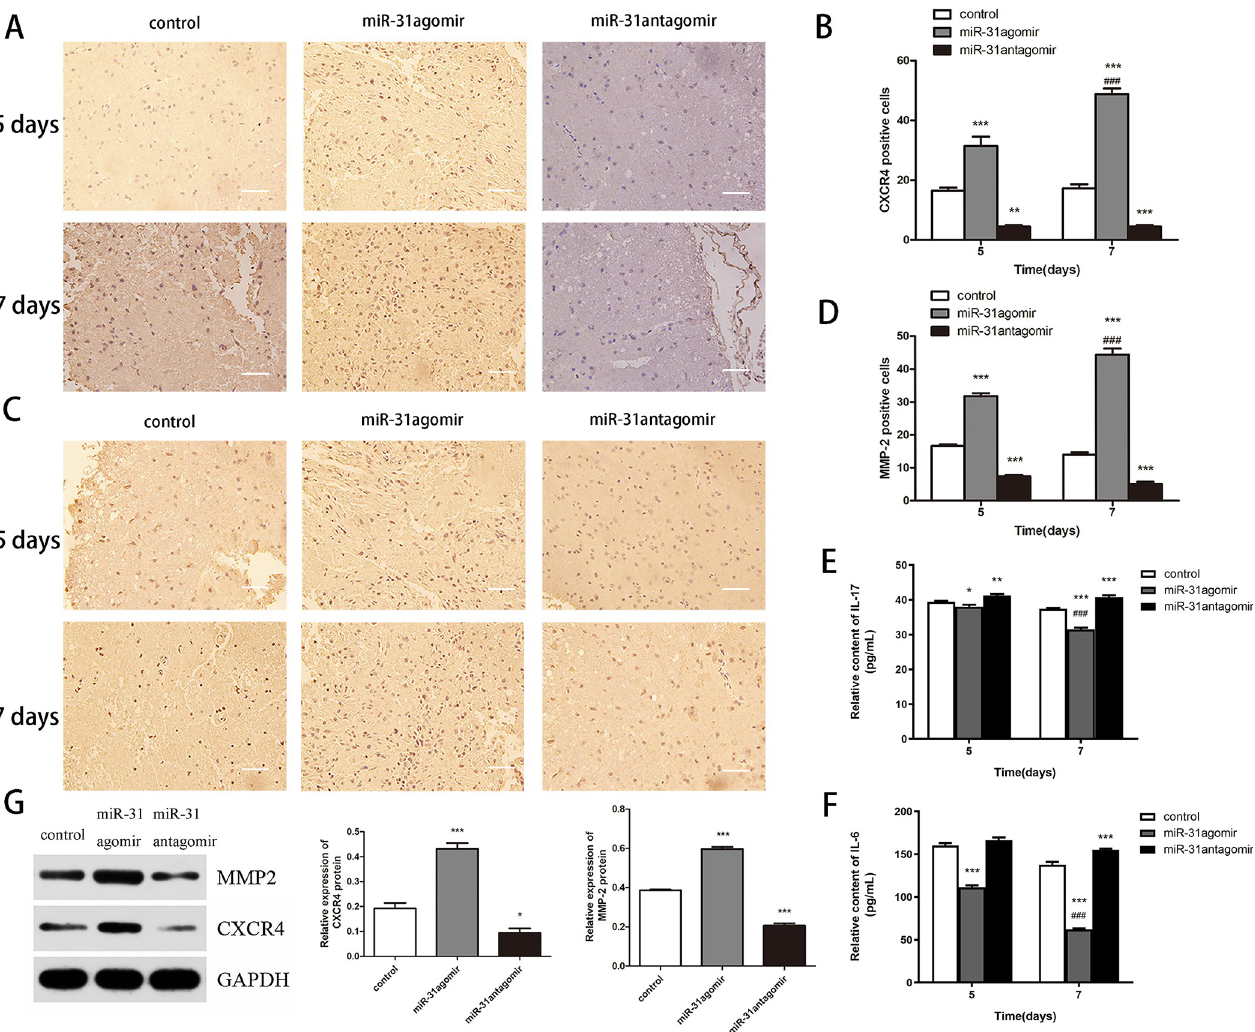
Fig 7. miR-31 upregulated the expression of CXCR4 and MMP-2 . A After cell transplantation, CXCR4 expression in tissues was detected by immunohistochemistry assays on days 5 and 7. Scar bar: 25 μ m. B Statistical results of CXCR4 expression in tissues. C After cell transplantation, MMP-2 expression in tissues was detected by immunohistochemistry assays on days 5 and 7. Scar bar: 25 μ m. D Statistical results of MMP-2 expression in tissues. E IL- 17 expression in vivo after cell transplantation. F IL-6 expression in vivo after cell transplantation. G After cell transplantation, CXCR4/MMP-2 protein expression was assessed in vivo by Western blot. Compared to control, � P < 0.05. Dates are presented as mean ± SD (n = 3,5,12). Statistical analysis: within group compared to control, � P < 0.05, �� P < 0.01, ��� P < 0.001; between groups compared to 5 days miR-31 agomir, ### P <